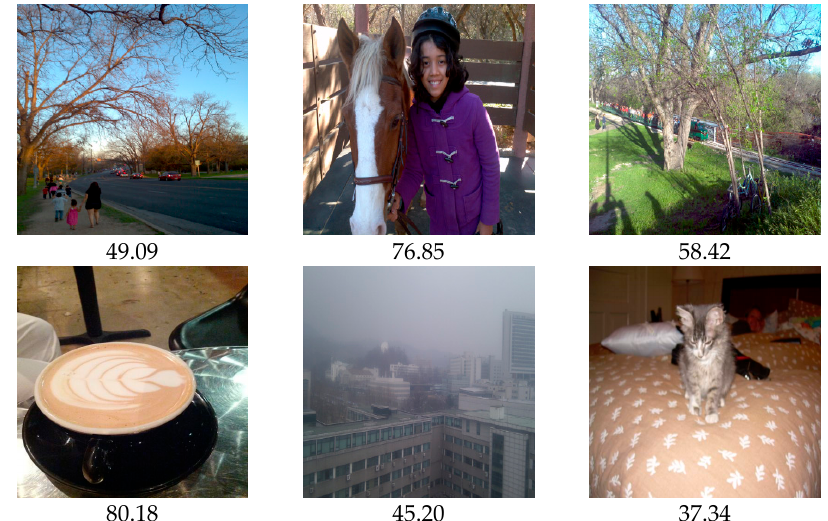
Figure 3. Examples of the LIVE In the Wild Image Quality Challenge database [15]. It consists of amounts of authentically distorted images. The number based the images are MOS (mean opinion scores), given by 8100 observers.